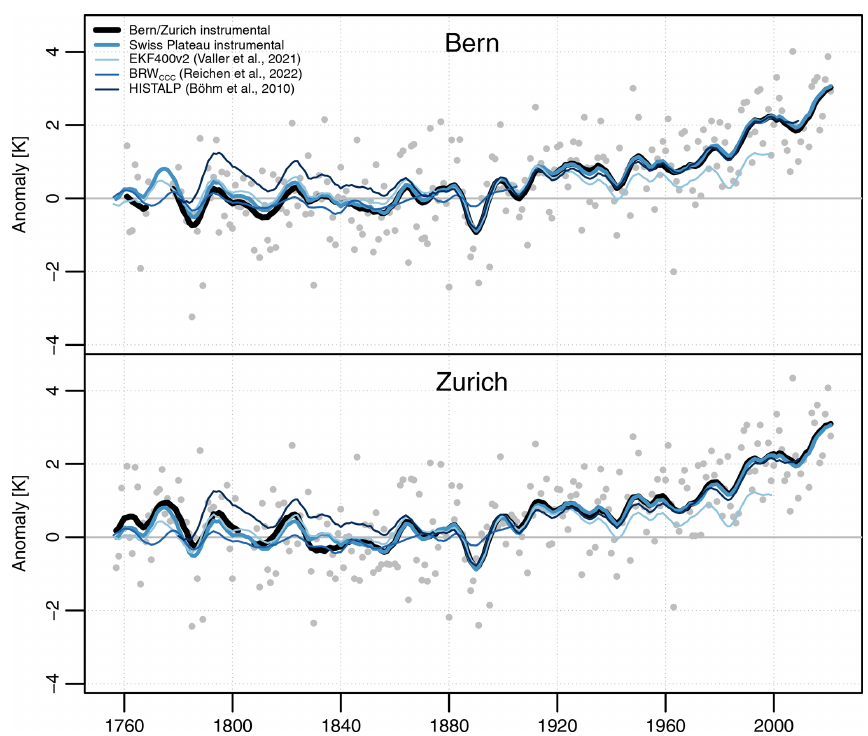
Figure 16. Smoothed time series of the cold season (October–March) mean temperature anomalies (with respect to the 1871–1900 average) for Bern and Zurich, as well as their average (thick lines). The thin lines show the cold season mean temperature anomalies from the nearest grid point in EKF400, HISTALP, and the cold season (October–May) reconstruction by Reichen et al. (2022). All data series were smoothed using a Gaussian filter with σ = 3 years. Dots represent the unsmoothed seasonal anomalies for Bern and